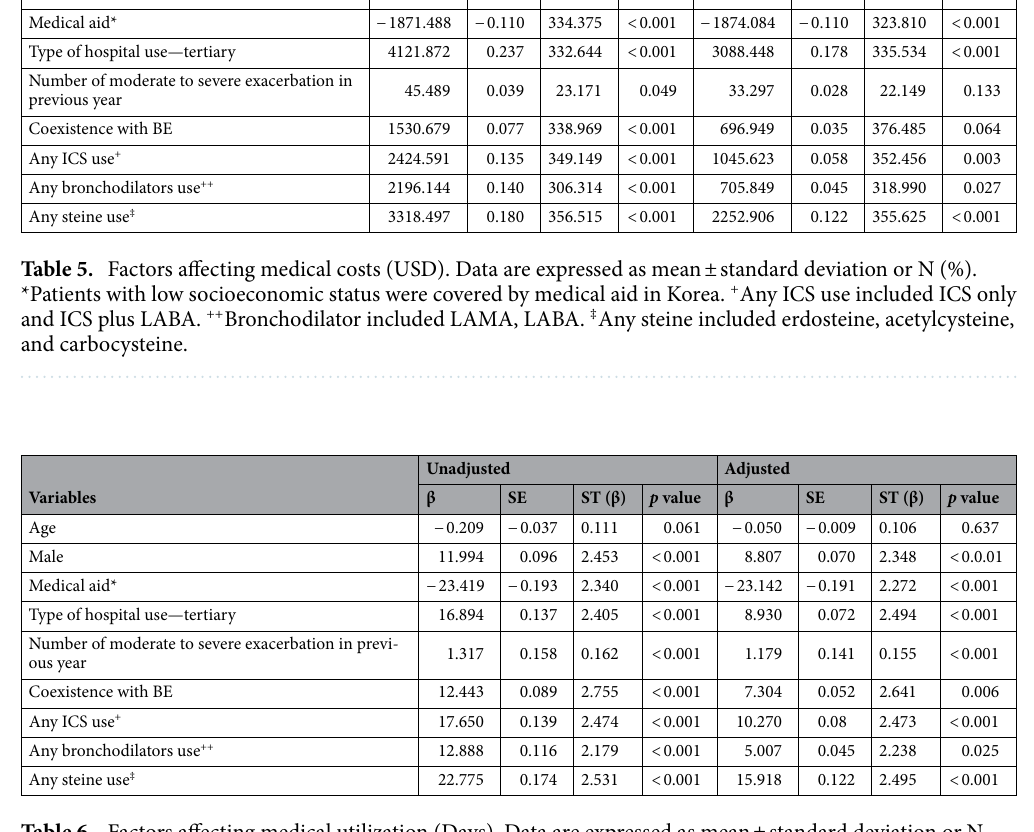
Table 6. Factors affecting medical utilization (Days). Data are expressed as mean ± standard deviation or N (%). *Patients with low socioeconomic status were covered by medical aid in Korea. + Any ICS use included ICS only and ICS plus LABA. ++ Bronchodilator included LAMA, LABA. ‡ Any steine included erdosteine, acetylcysteine, and